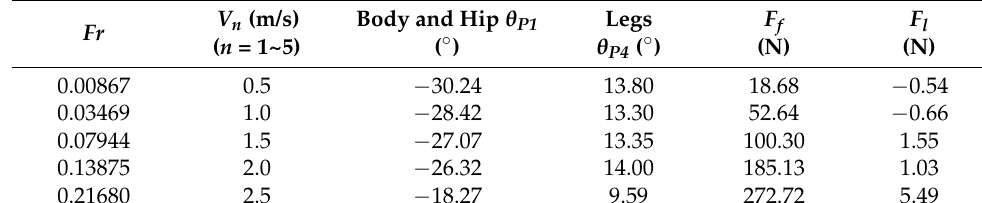
Table 6. DPV resistance and posture angle at different speeds.